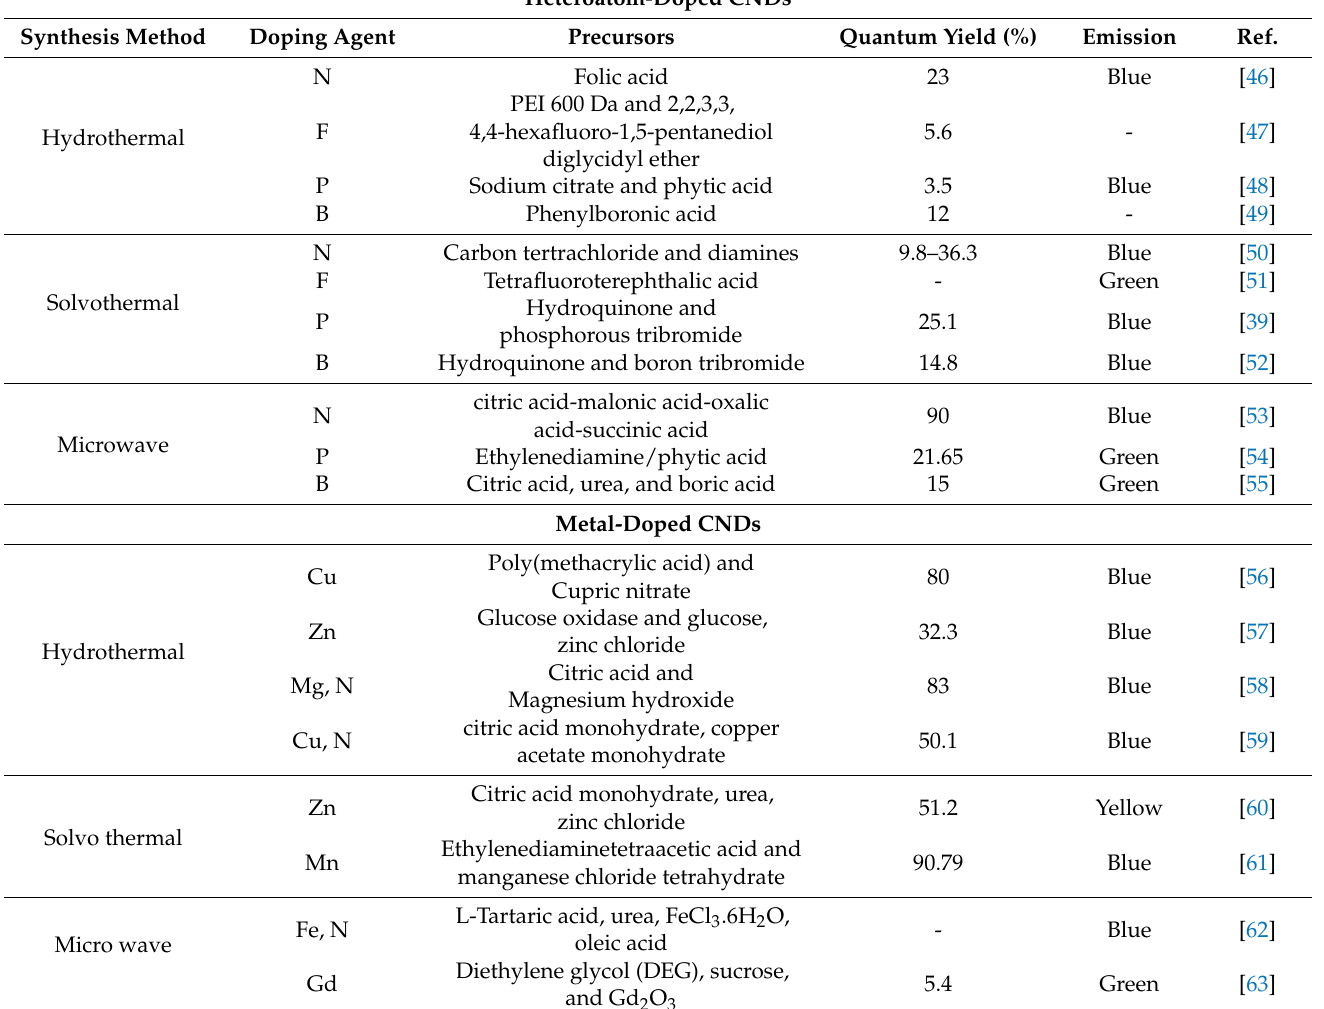
Table 1. Heteroatom/metal-doped CNDs along with their synthesis methods, quantum yields, and colors. Heteroatom-Doped